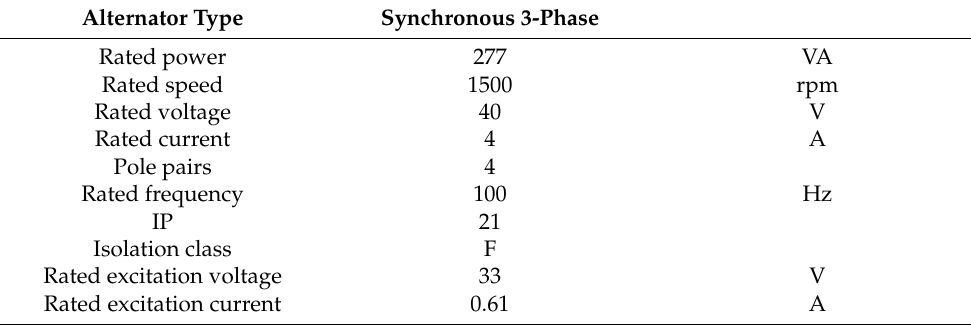
Table 3. Exciter